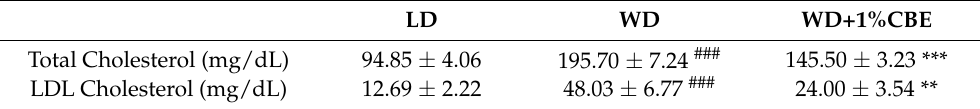
Table 1. Serum total and LDL cholesterol levels of the mice fed with LD, WD, or WD+1%CBE for 12 weeks.